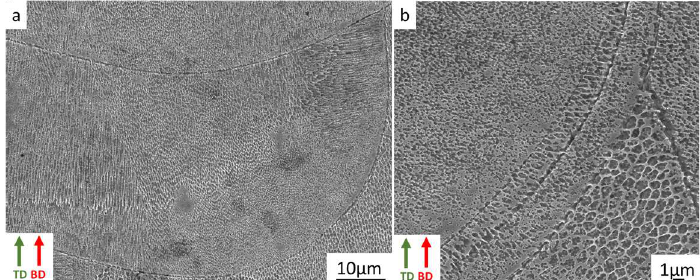
Fig. 3. SEM images of Bd0_t1 at two magnifications showing the subgrain structure inside a meltpool (a) and close to a melt pool boundary (b) along the Tensile Direction (TD) with respect to the Building Direction